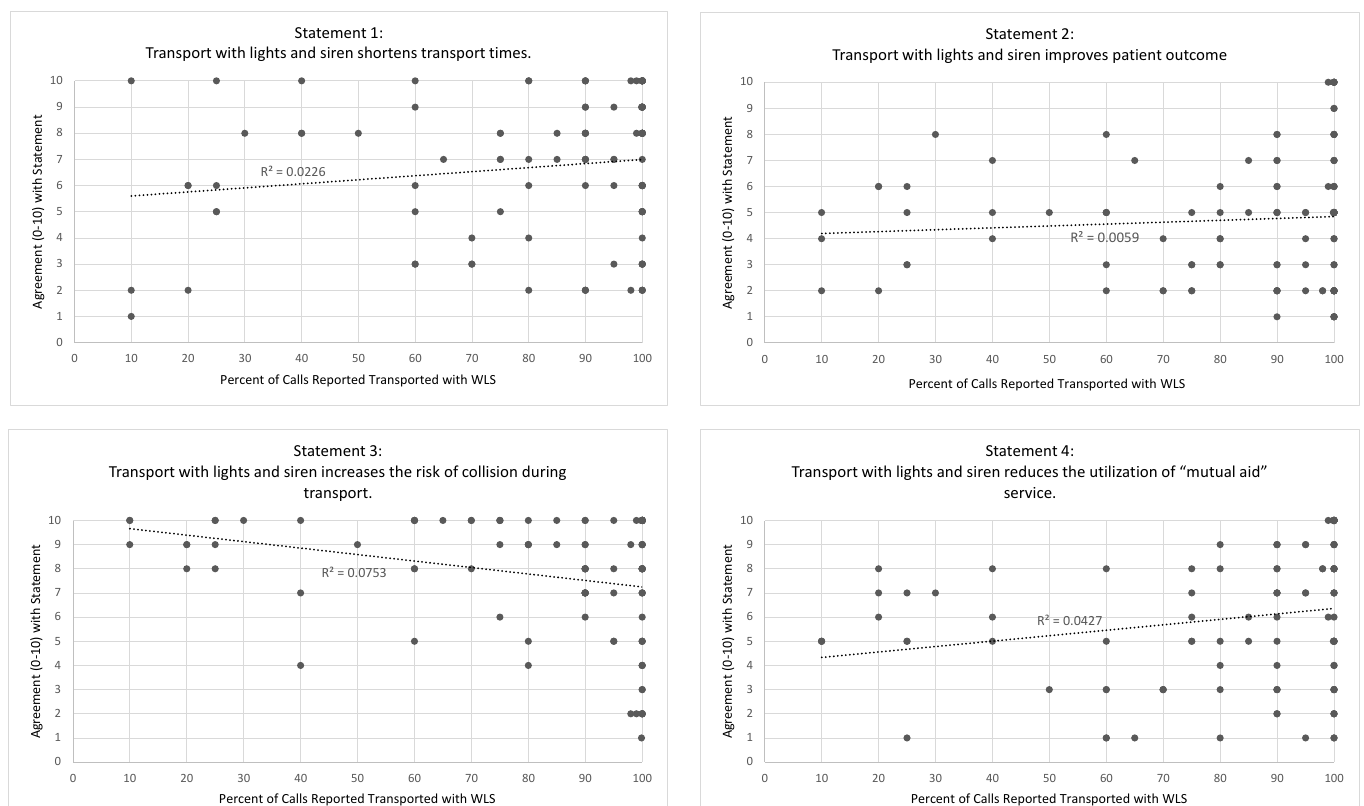
Figure 4. Comparison of statement responses with providers’ reported warning lights and siren (WLS)